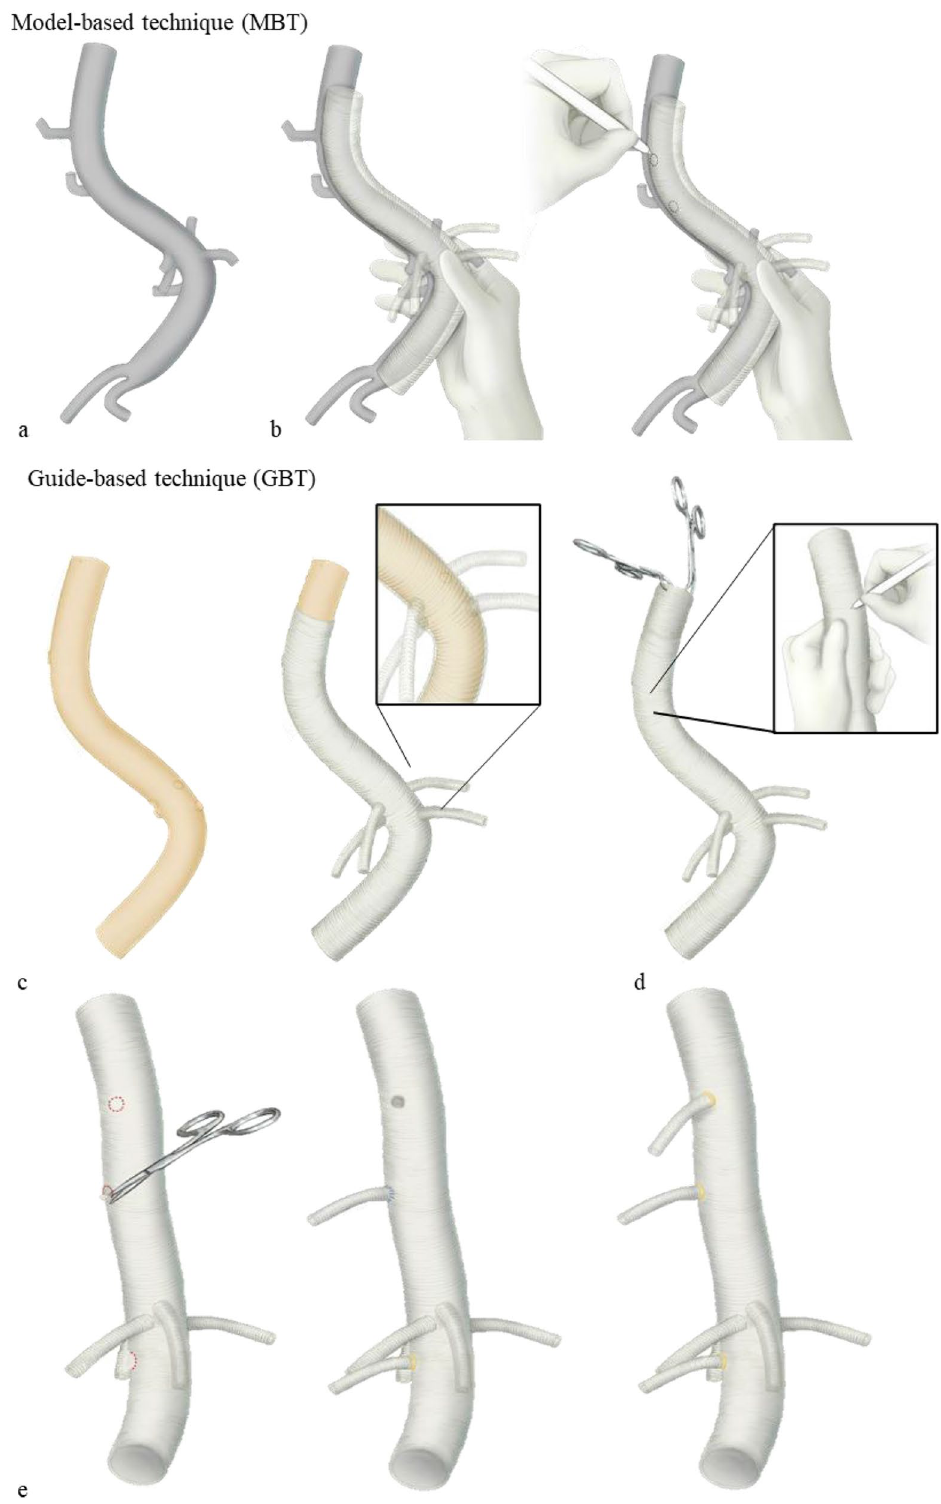
Figure 3. Patient-specific graft reconstruction process with MBT and GBT in operating